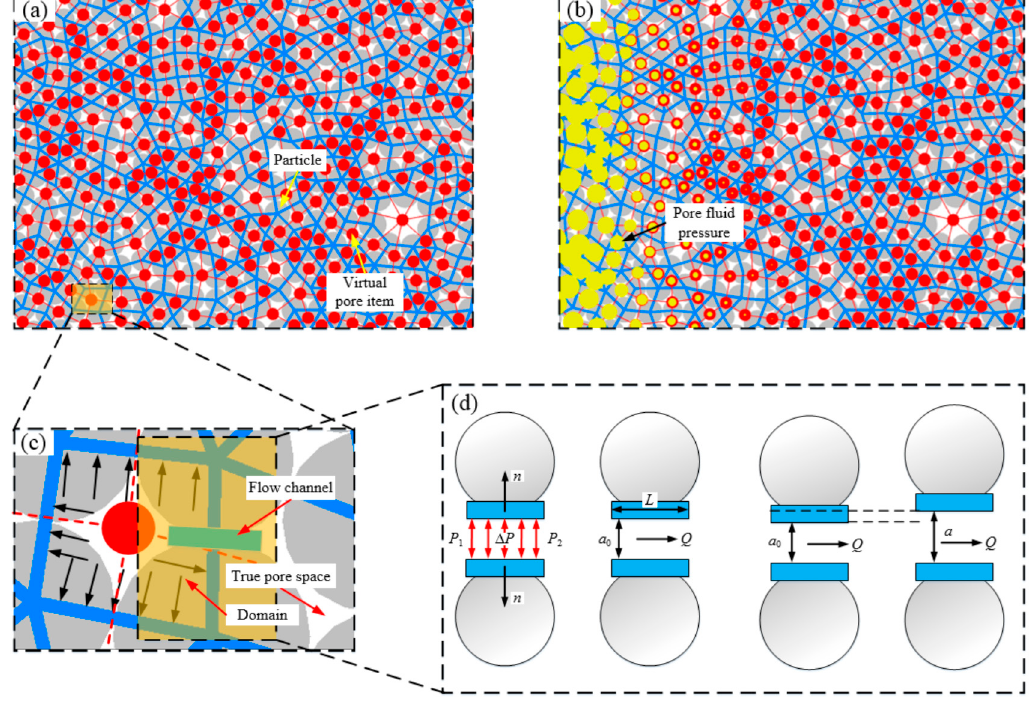
Figure 3. ( a ) Coupled hydro-mechanical model; ( b ) Pore pressure build up; ( c ) Domain and flow channel; and ( d ) Hydraulic aperture.